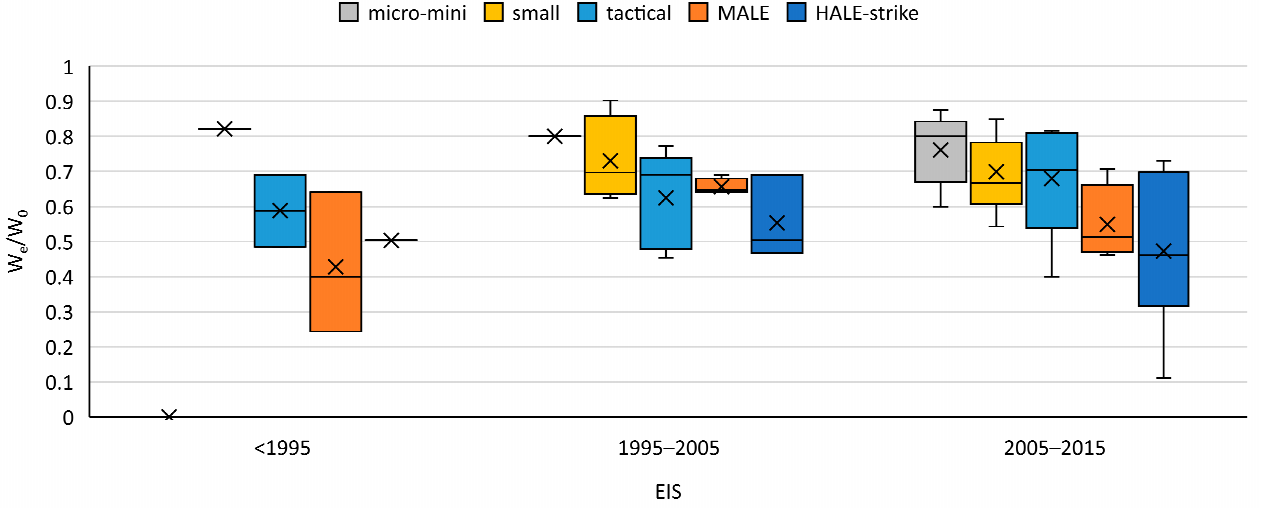
Figure 25. Empty weight ratio EIS progression per NATO category.